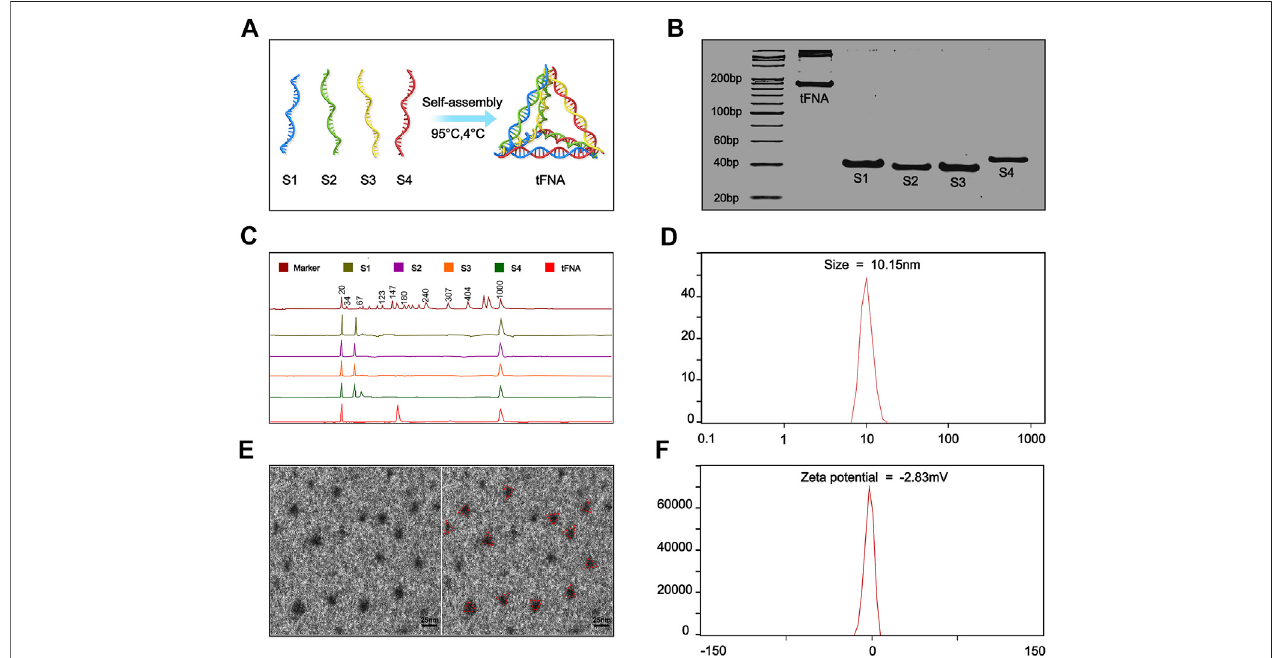
FIGURE 1 | General characteristics of tFNA. (A) Synthesis of tFNA. (B) The successfully synthesis of tFNA con fi rmed by 8% PAGE. (C) The molecular weight of ssDNA and tFNA detected by high performance capillary electrophoresis. (D) The size of tFNA. (E) The size and distribution of tFNA analyzed by transmission electron microscope (red triangle). Scale bars are 25 nm. (F) The Zeta potential of tFNA. This article was published in Applied Materials Today, vol.24, Yuting Yang, The remyelination effect of DNA framework nucleic acids on demyelinating diseases, Page No.1-3, Copyright Elsevier.